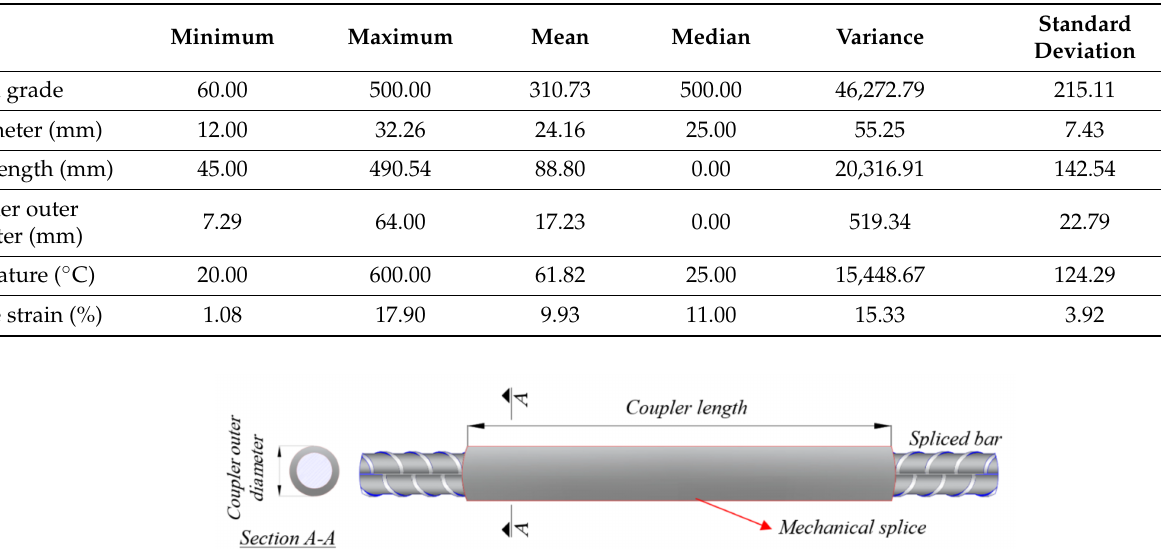
Table 2. Statistical properties of the input and output parameters.